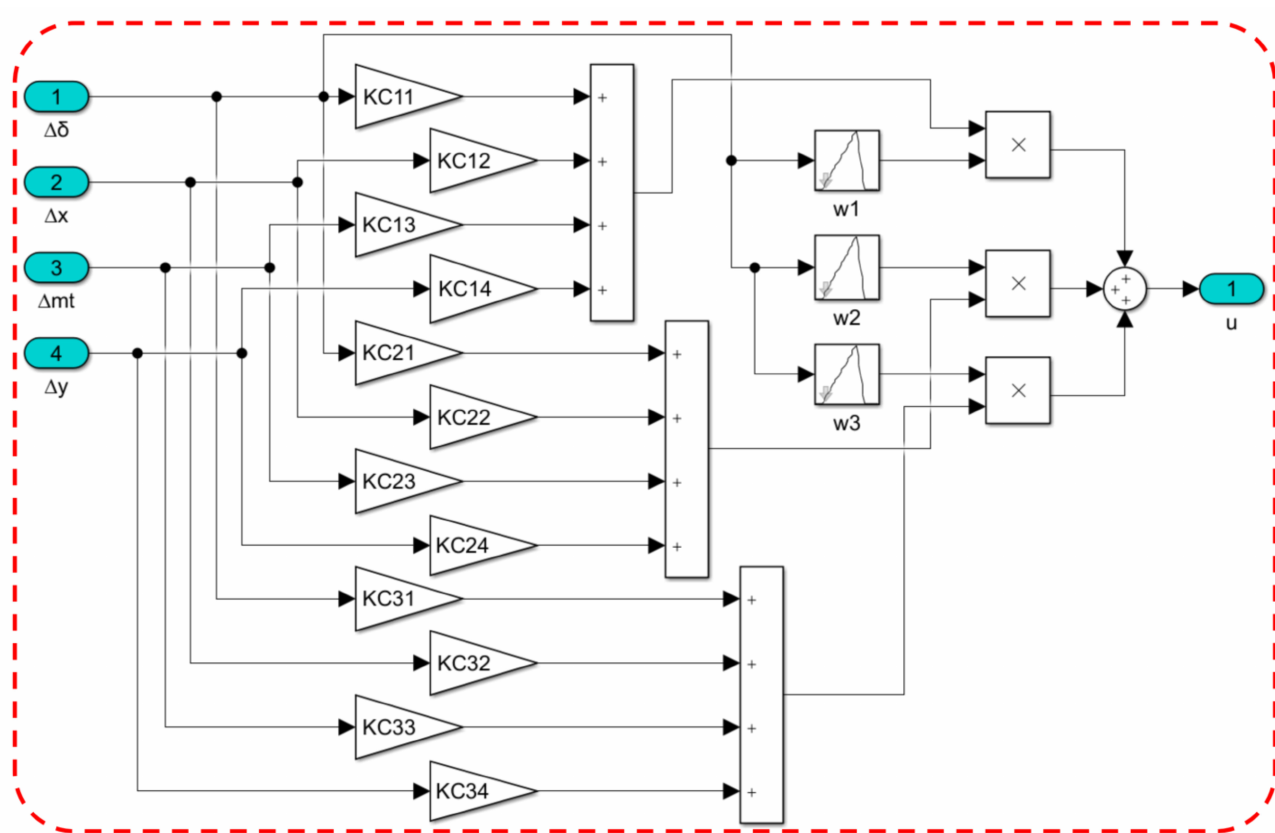
Figure 11. Simulation model of